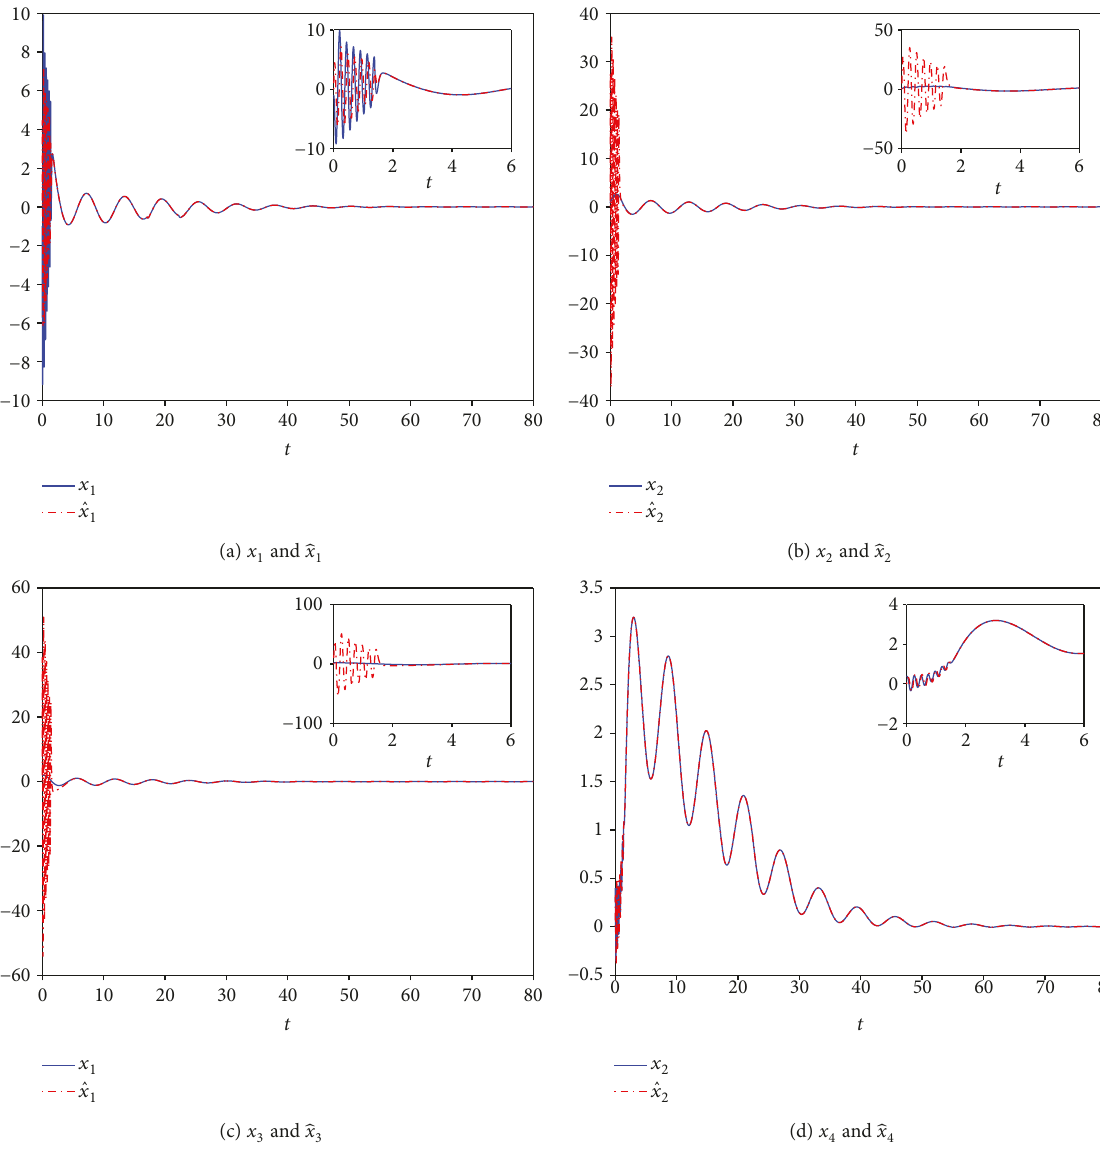
Figure 6: Time responses of the state variables in (35) under observer-based fuzzy